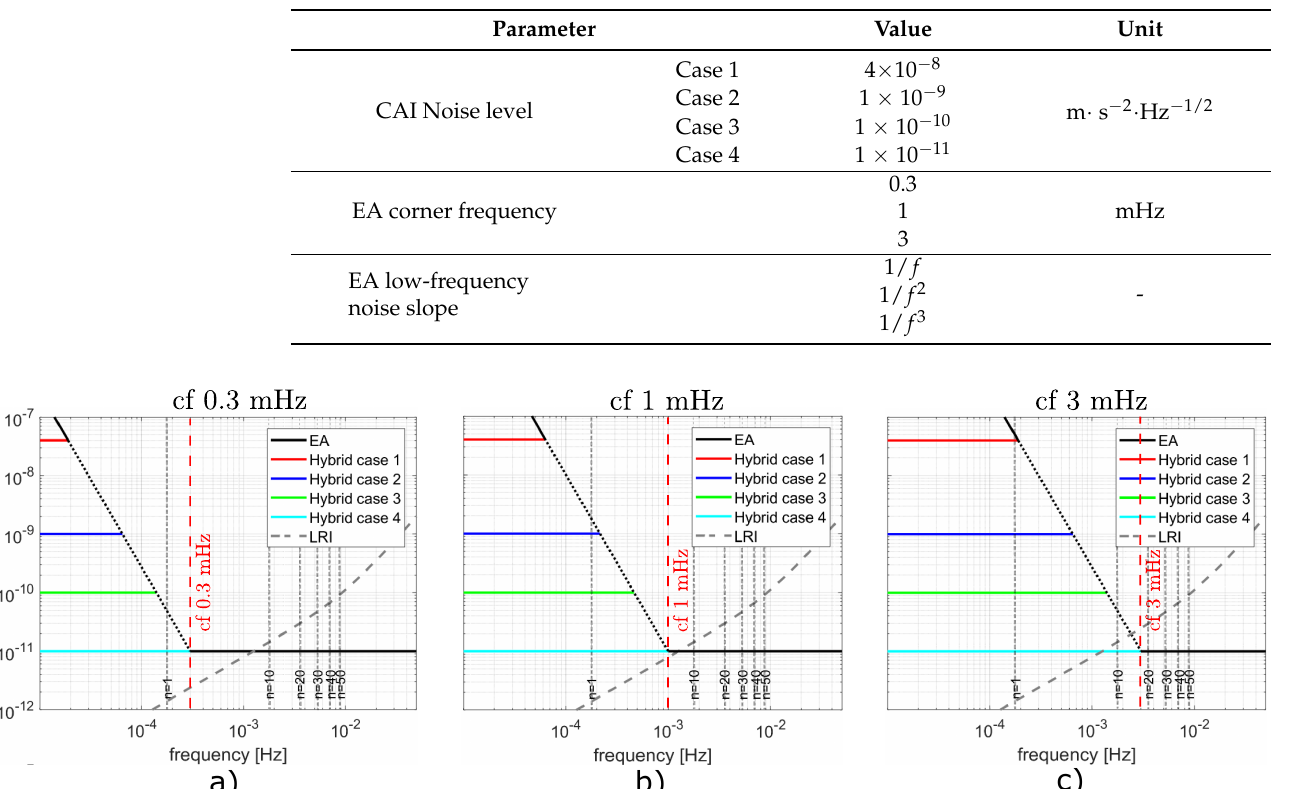
Table 2. Accelerometer parameters for simulations.